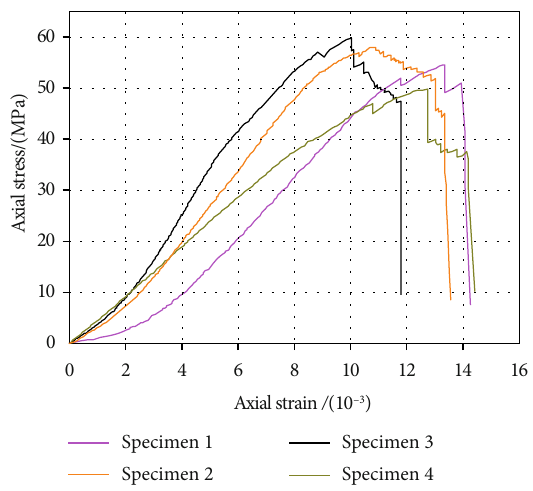
Figure 9: Axial stress-strain